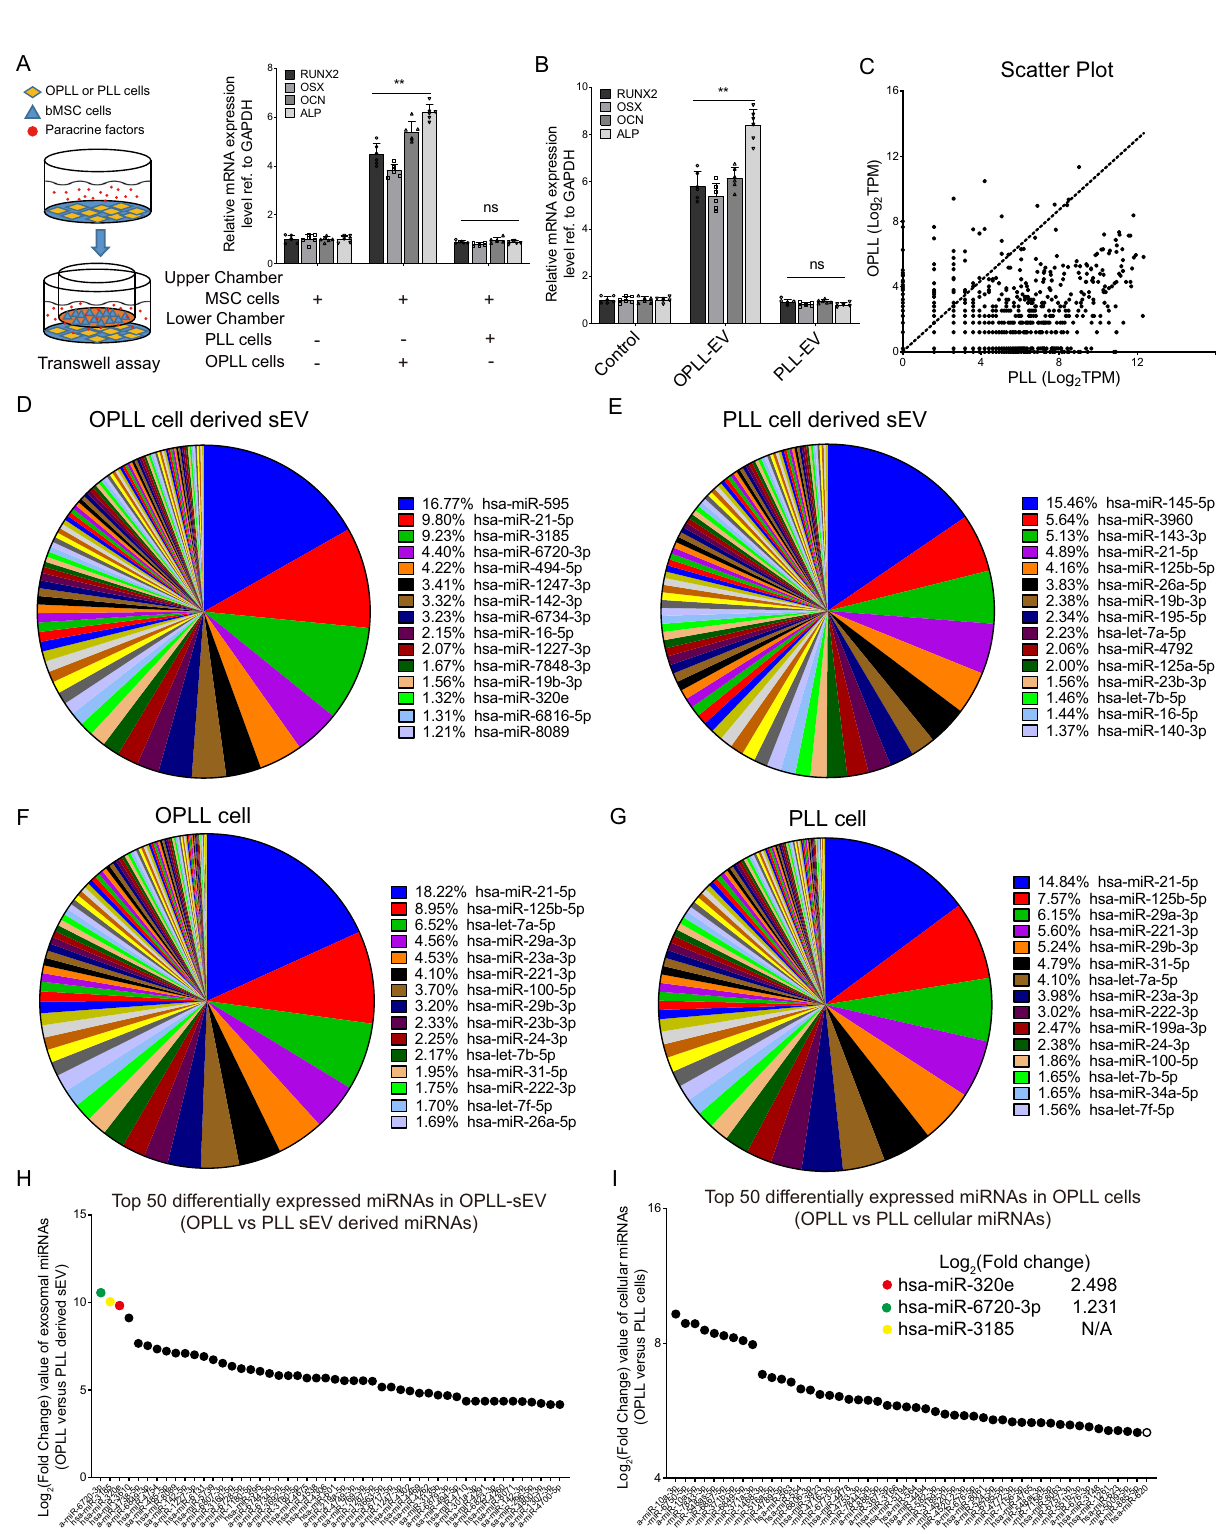
TAK1 is targeted by miR-320e in OPLL . To explore the underlying mechanism of miR-320e, we took advantage of our previous OPLL and PLL cellular transcriptome data and miRanda miRNA target prediction algorithm. We screened for ossi fi cation- related candidates and found that 8 potential targets were sig- ni fi cantly decreased in OPLL cells (Fig. 6A). Using miRNA mimic overexpression in PLL cells, we found that only the expression of